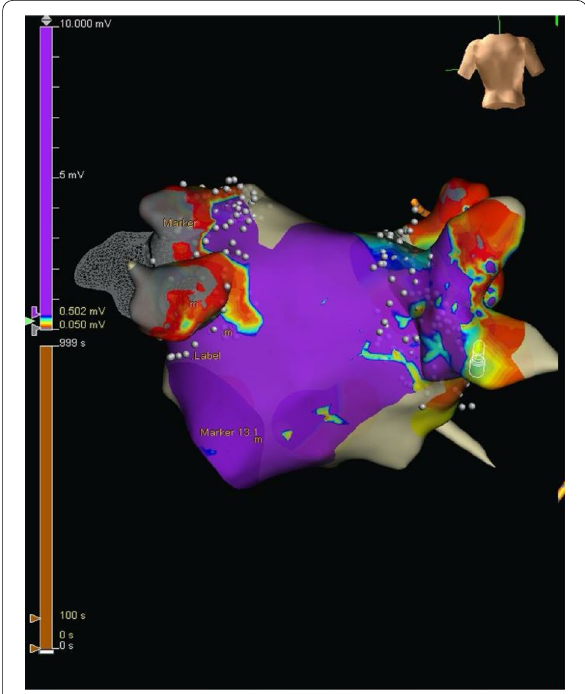
Fig. 5 Post PVI voltage mapping revealed acute reconnection of left superior pulmonary vein and right inferior pulmonary vein. The patient had history of secundum atrial septal defect